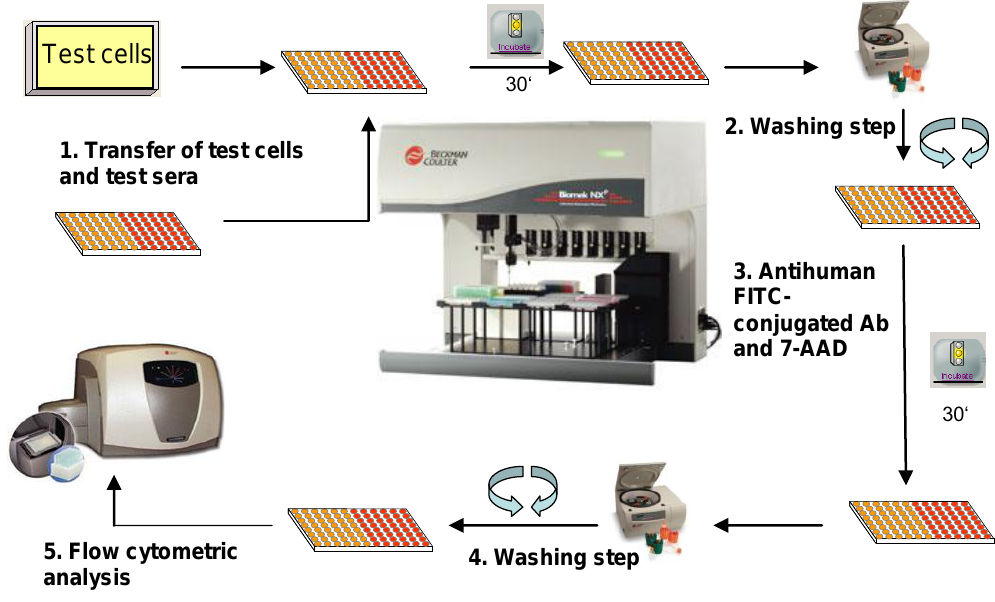
FIGURE 1 . The principle of the automated Flow-GIFT. Test sera were prepared in a 96-deep well plate. The first column includes negative controls (positions 1 and 2) and positive controls (positions 3–8). Columns 2–12 include testing sera. Test cells were manually isolated